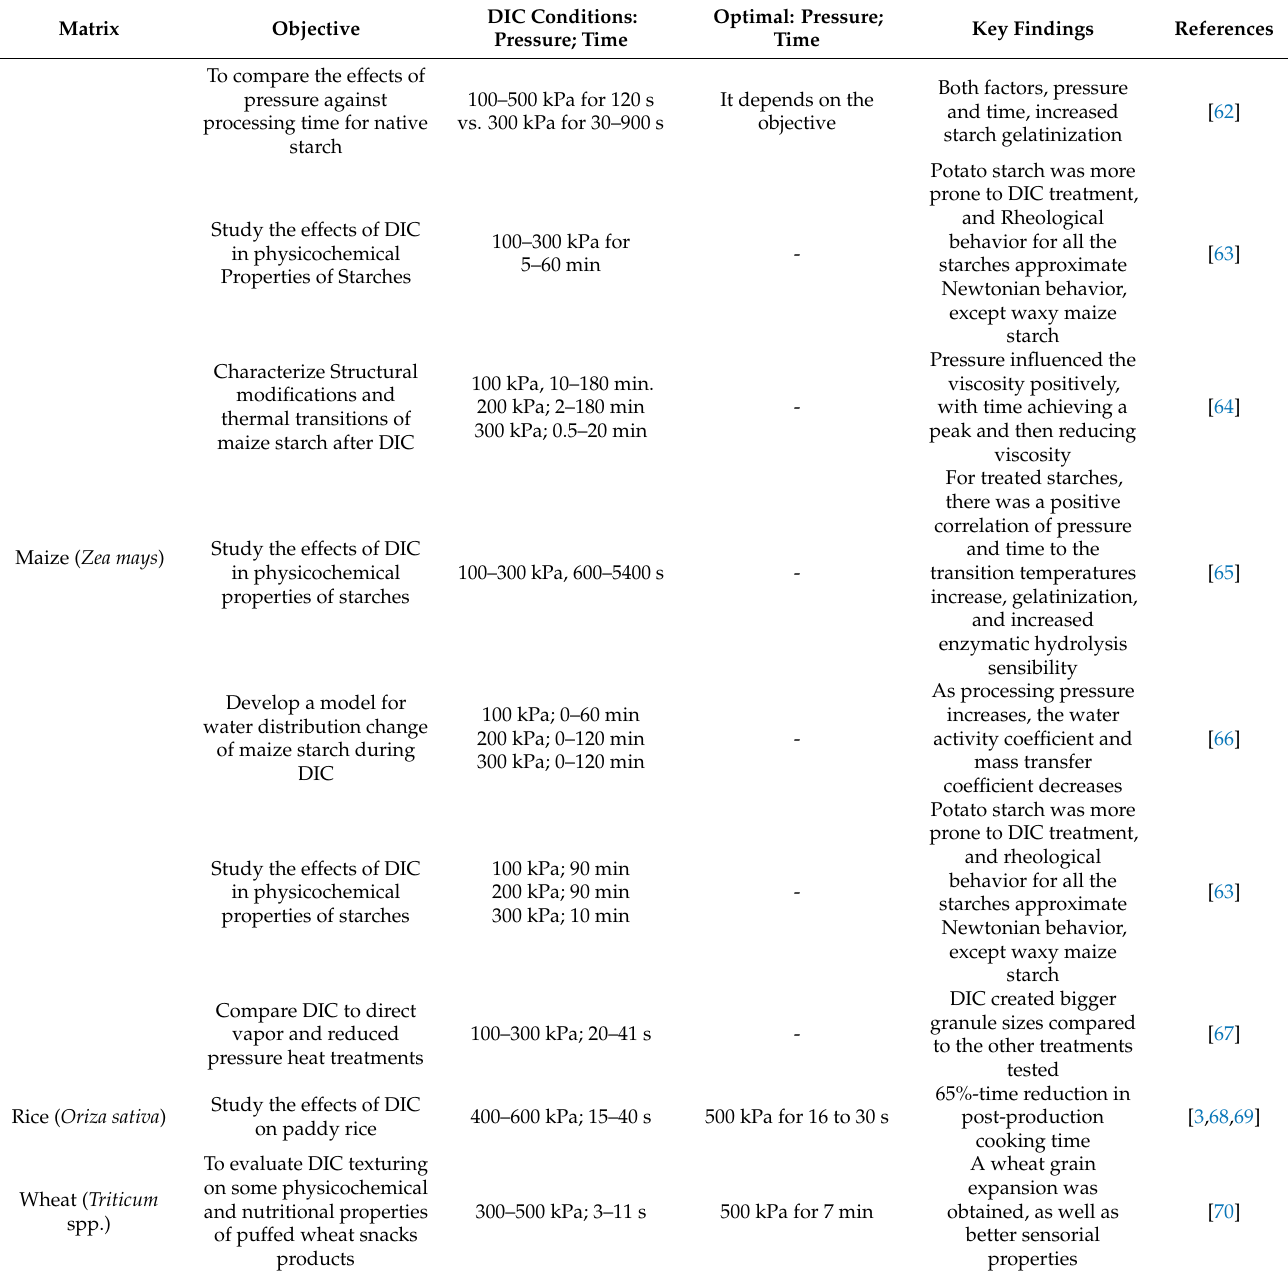
Table 4. Summary of the DIC conditions observed in the treatment of cereals and some key findings.